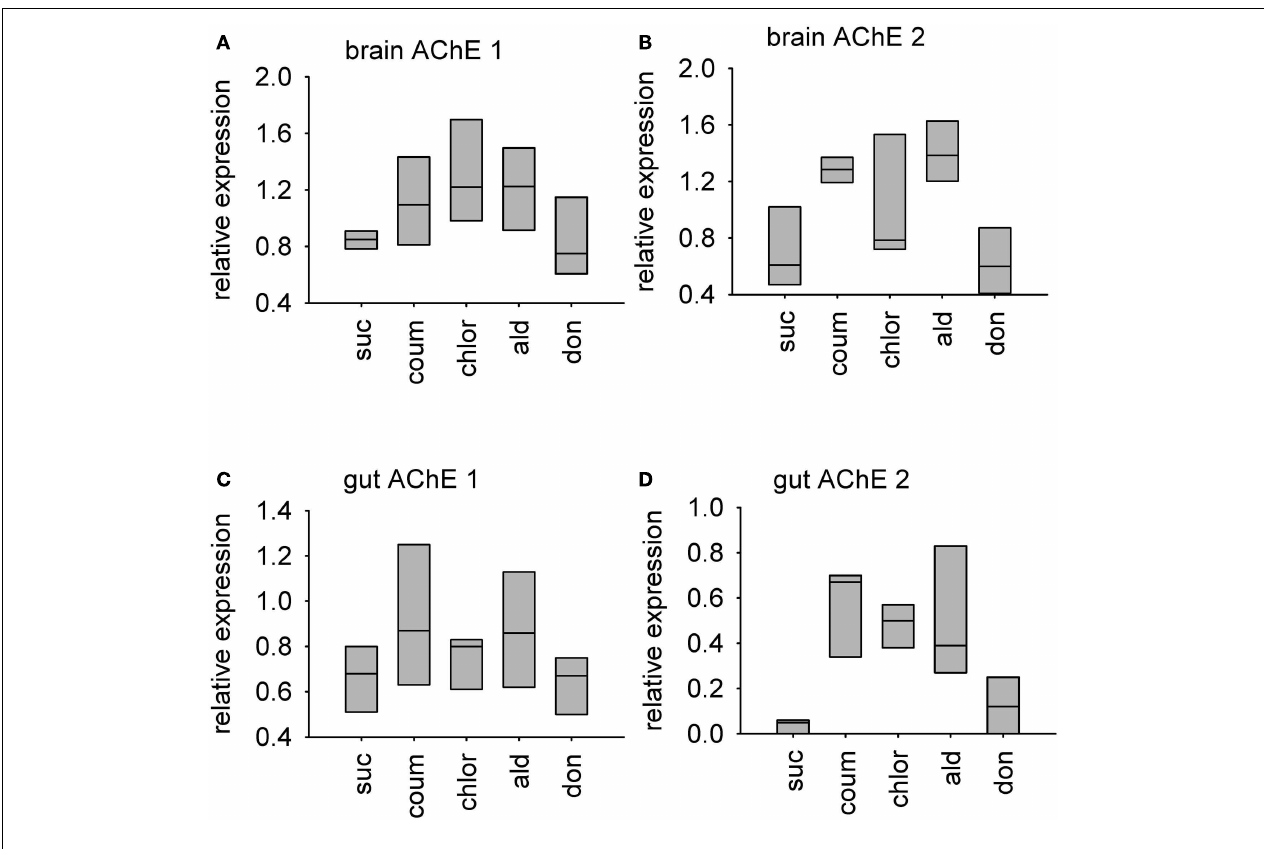
or brains from five individuals collected from eat treatment group. (A) AChE-1 transcript in brain tissue (B) AChE-2 transcript in brain tissue (C) AChE-1 transcript in gut tissue (D) AChE-2 transcript in gut tissue. Suc, sucrose; Coum, coumaphos; Chlor, chlorpyrifos; Ald, aldicarb; Don,